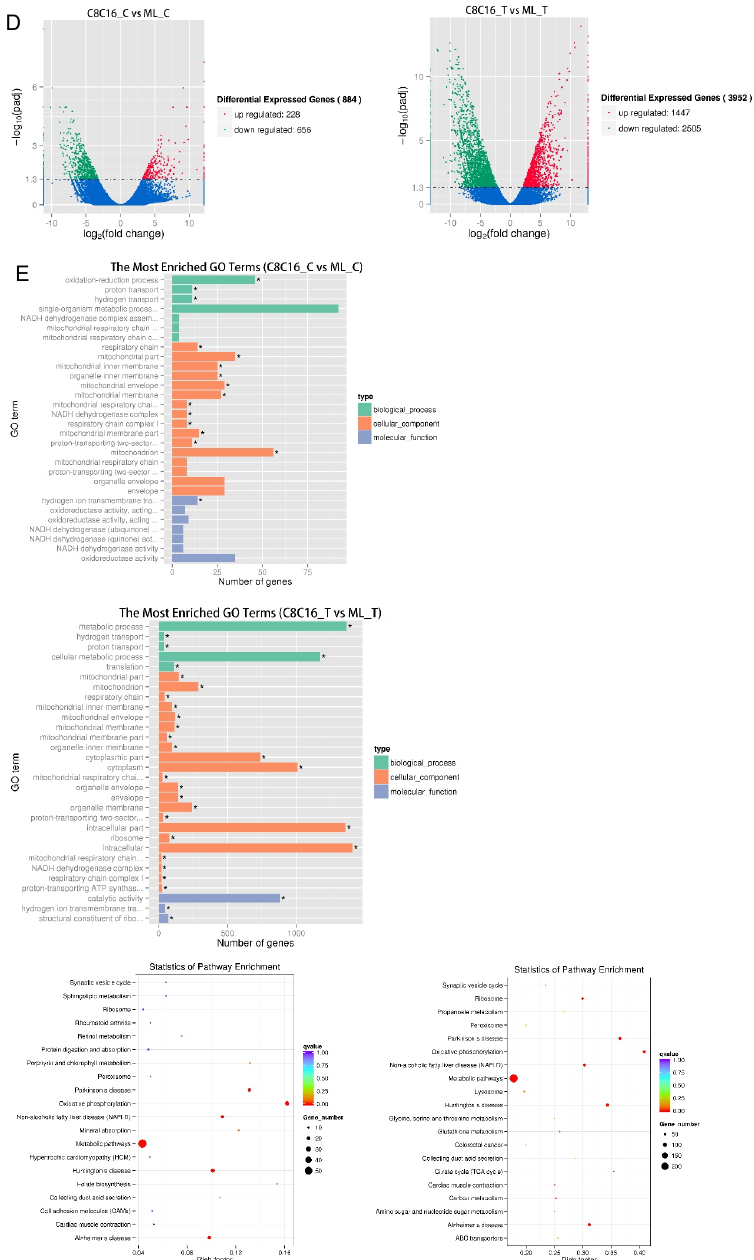
Figure 2. Di ff erentially expressed genes (DEGs) during embryo development from the 8-16-cell stage to morula with or without glutathione treatment. ( A ) Venn diagram of DEGs between the two groups. The yellow area represents the DEGs in the GSH-treated embryos; the purple area, DEGs in the untreated embryos; and the overlapping area, DEGs common between the two groups of embryos. ( B ) Hierarchical clustering of DEGs between the 8-16-cell stage embryos and morula with or without GSH treatment. The color spectrum indicates normalized levels of gene expression. ( C ) Venn diagram of unique DEGs in each group of embryos. The blue area represents unique DEGs in GSH-treated embryos; the orange area, unique DEGs in the untreated group; and the overlapping area, unique DEGs common to the two groups. ( D ) Volcano plots showing fold change of up- or down-regulated genes or unchanged (blue) genes between the untreated (left) and GSH-treated (right) groups. ( E ) GO analysis (top row) and KEGG analysis (bottom row) of DEGs during embryo development from the 8-16-cell stage to morula with or without GSH